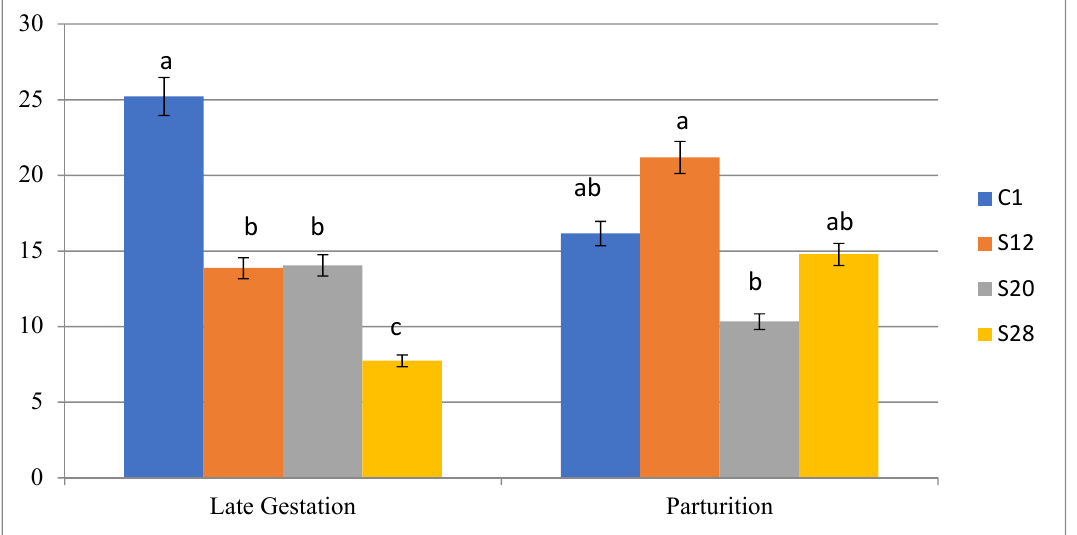
Figure 2. The effects of different levels of sunflower hulls in total mixed ration on Awassi ewe’s nonesterified fatty acids level (mg/dL) during different physiological periods. Different letters indicate significant differences. Table 5. The effects of different levels of sunflower hulls in total mixed ration on reproductive parameters of Awassi ewes. Treatment